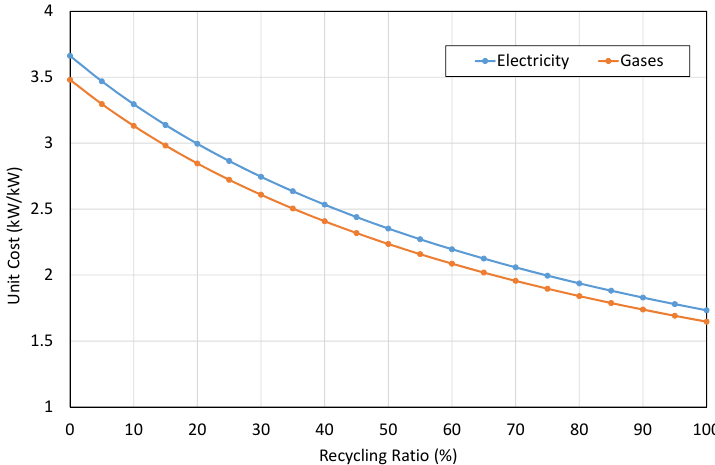
Figure 9. Recycling saving graph for the TGAS